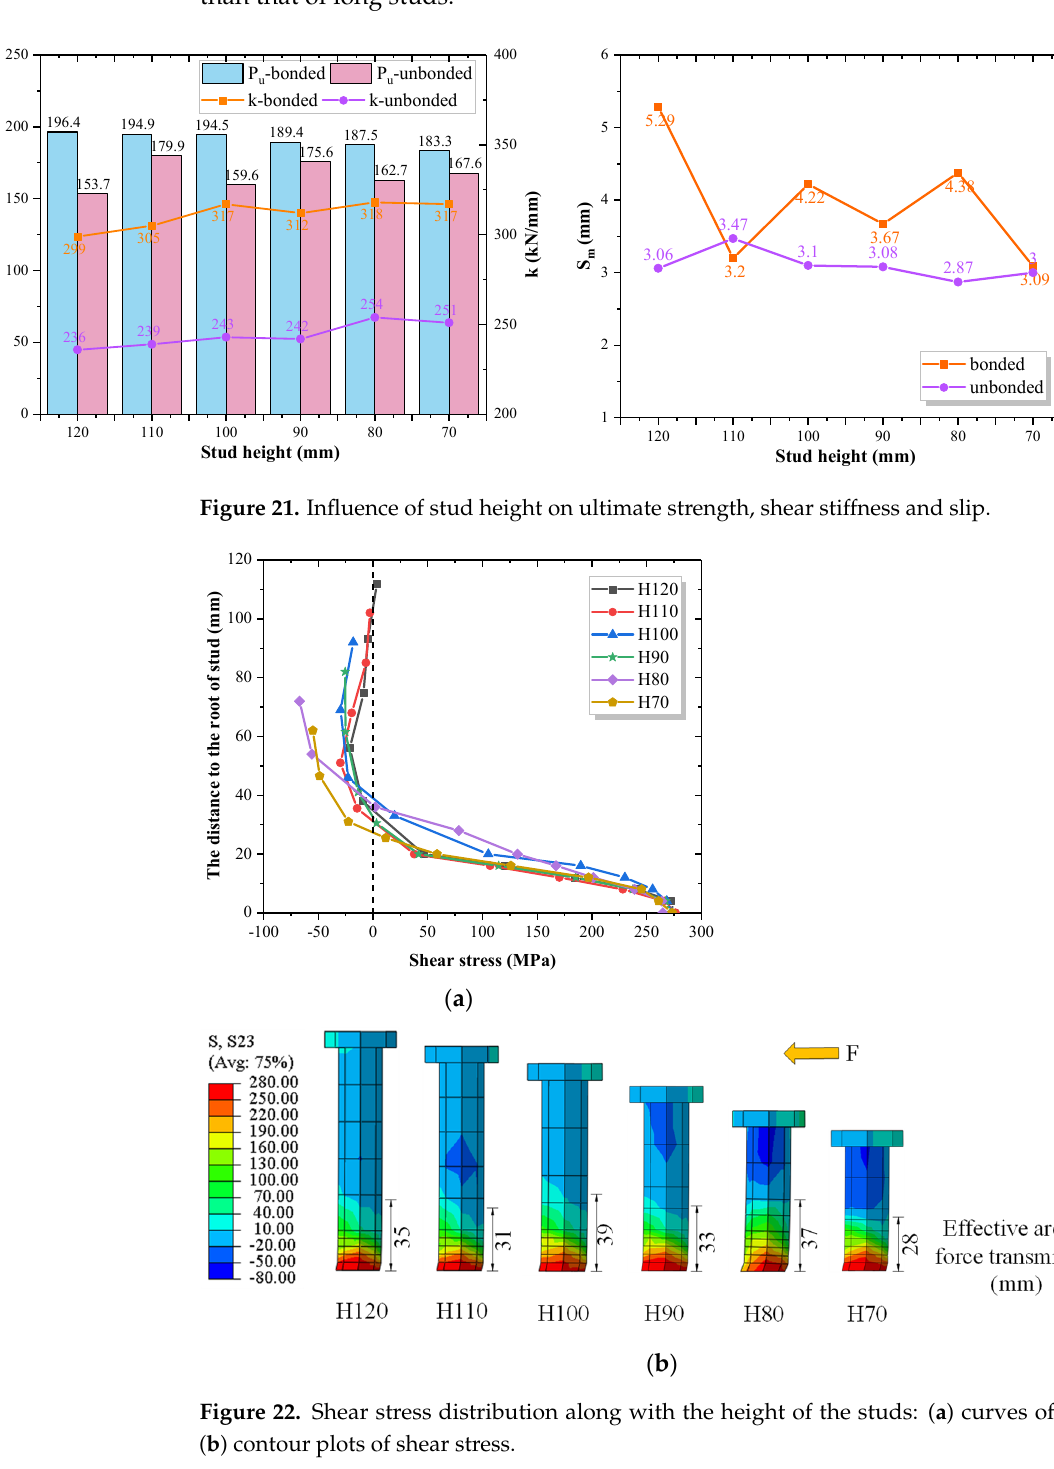
Figure 20. Load-slip curves of specimens with different stud height.